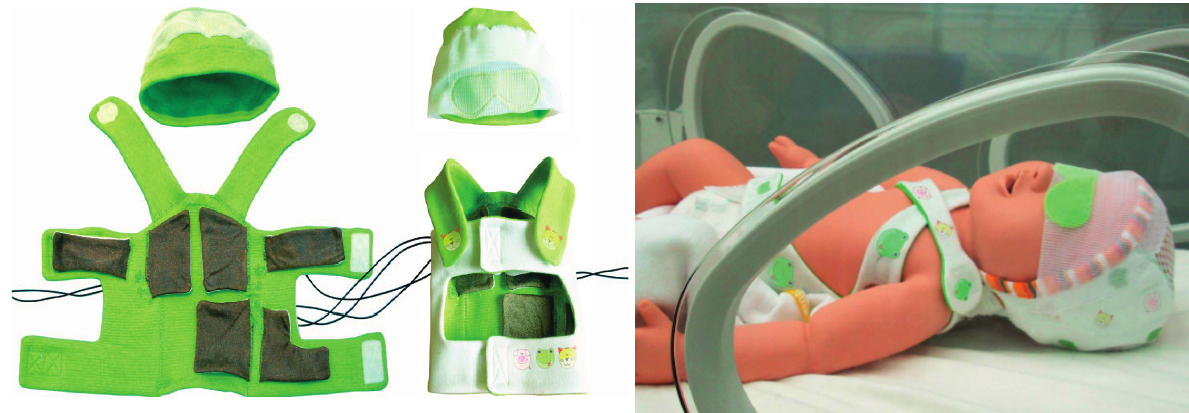
Figure 17. A prototype of the smart jacket ( left ) and a baby mannequin wearing the smart jacket inside the incubator ( right ) [11]. Copyright © 2009